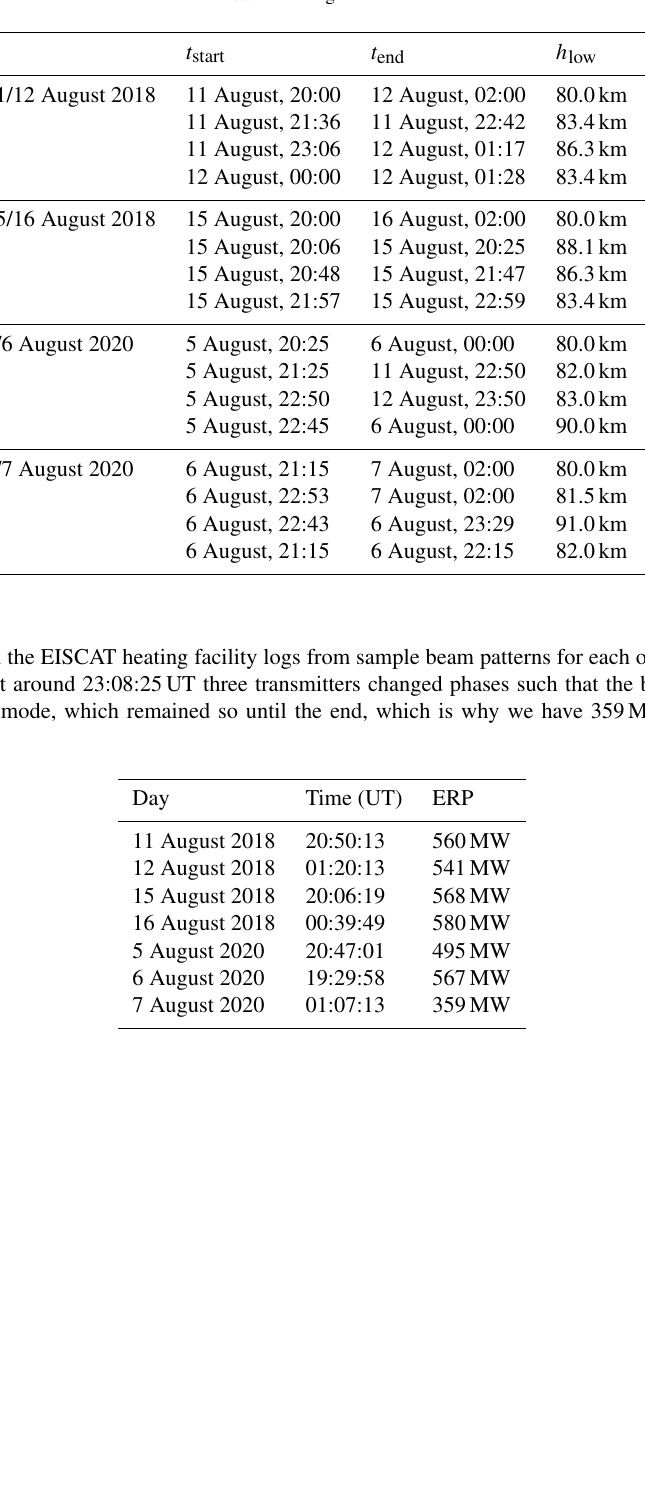
Table A1. Days of measurements and selected areas. Symbols t start and t end define the beginning and the end of the area. The altitude of the atmosphere, where the analysis is done, is described with h low and h high .